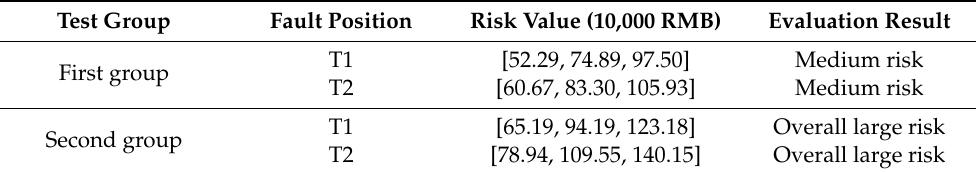
Table 14. Comparison of the evaluation results at different fault